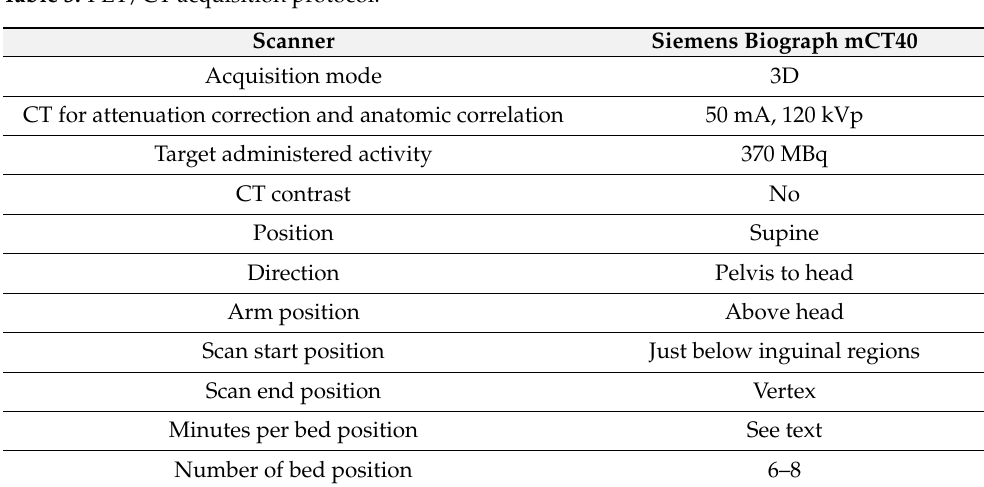
Table 3. PET/CT acquisition